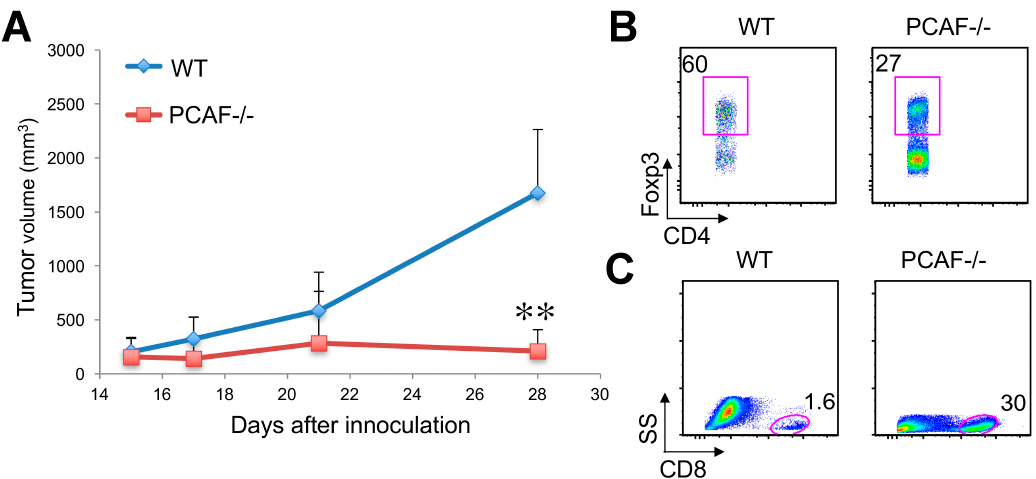
Figure 7. PCAF targeting inhibits tumor growth. ( A ) TC1 tumor growth in WT and PCAF − / − C57BL / 6 mice (tumor volumes shown as mean ± SD, ** p < 0.01 by Mann–Whitney U test). Additional panels show flow cytometric analyses of the frequency of ( B ) CD4 + Foxp3 + Tregs and ( C ) CD8 + T cells population within TC1 tumors. Data are representative of 2 separate experiments, with 10 mice/group.